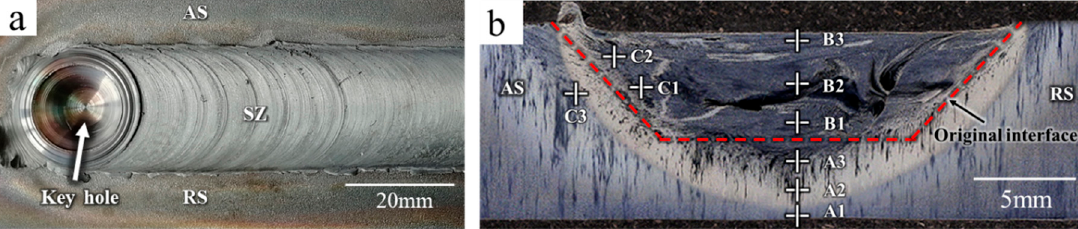
Figure 5. Results of ultrasonic phased array detection: ( a ) photo of the signal detected for a defect consisting of a 0.1 ϕ hole, ( b ) photo of the signal detected for the repaired sample.